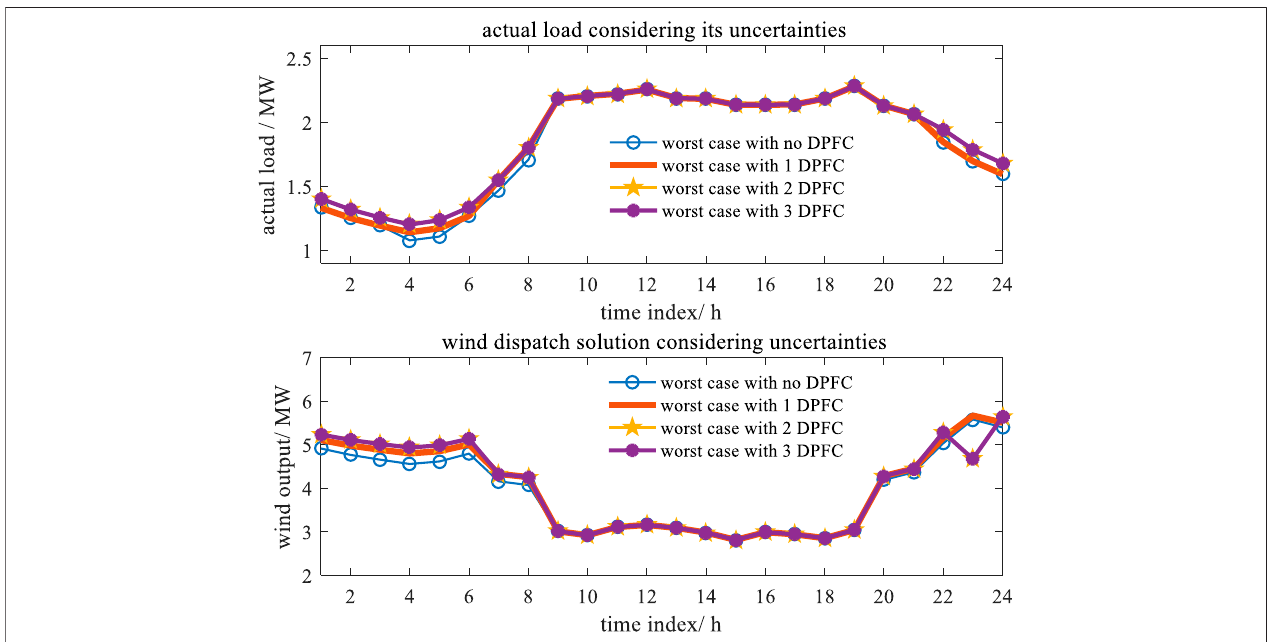
FIGURE 11 | Wind upper/lower bound and its worst-case scenario with different numbers of the DPFC.